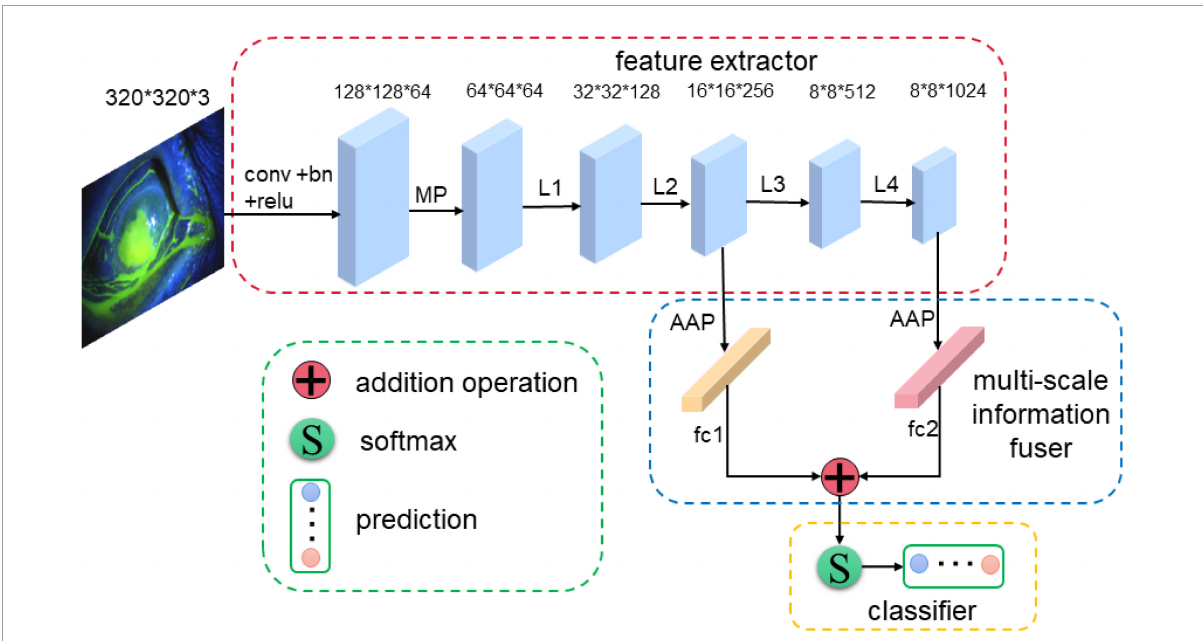
FIGURE2 An overview of the proposed MIF-Net for corneal ulcer classification in slit lamp images. The MIF-Net consists of feature extractor, multi-scale information fuser, and classifier, where the feature extractor, multi-scale information fuser, and classifier are in red, blue, and yellow dashed boxes, respectively. “MP,” “GAP,” and “fc” represent max pooling operator, global average pooling operator, fully connected operator,